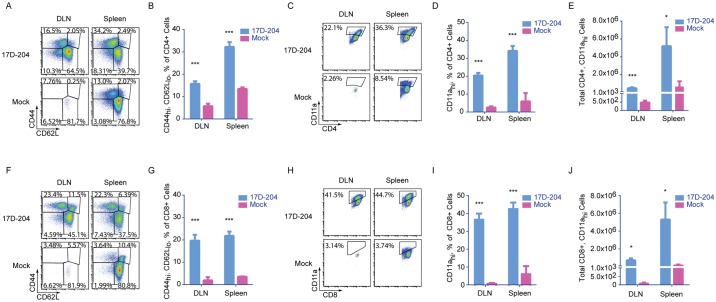
17D-204 immunization induces robust T cell responses.5–6 week old mice were immunized with 17D-204. On d7 post immunization DLNs and spleens were harvested and (A-E) CD4+ and (F-J) CD8+ T cells were screened by flow cytometry for the expression of (A-B, F-G) CD44 and CD62L and (C-E, H-J) CD11a. Results are representative of two experiments (n = 3 mock, n = 6 17D-204). Data are displayed as mean ± SD. ***, p≤ 0.0001; *, p≤0.01 as determined by a Student's t-test).